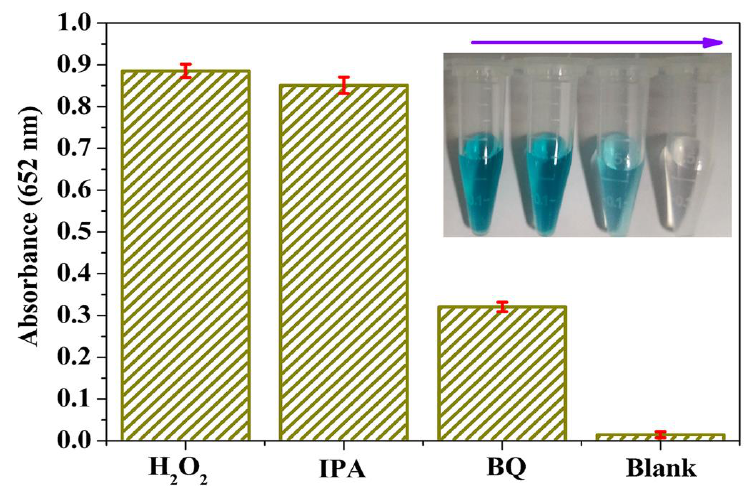
Figure 5. Time-dependent absorbance of reaction solutions at 652 nm in the absence or presence of scavengers (10 mM of IPA and BQ) containing 25.0 mM PBS (pH = 4.0), 2.0 mM H 2 O 2 , 0.8 mM TMB, and 120 μg/mL MoS 2 @CNNS(30) at room temperature. Inset: related color changes.